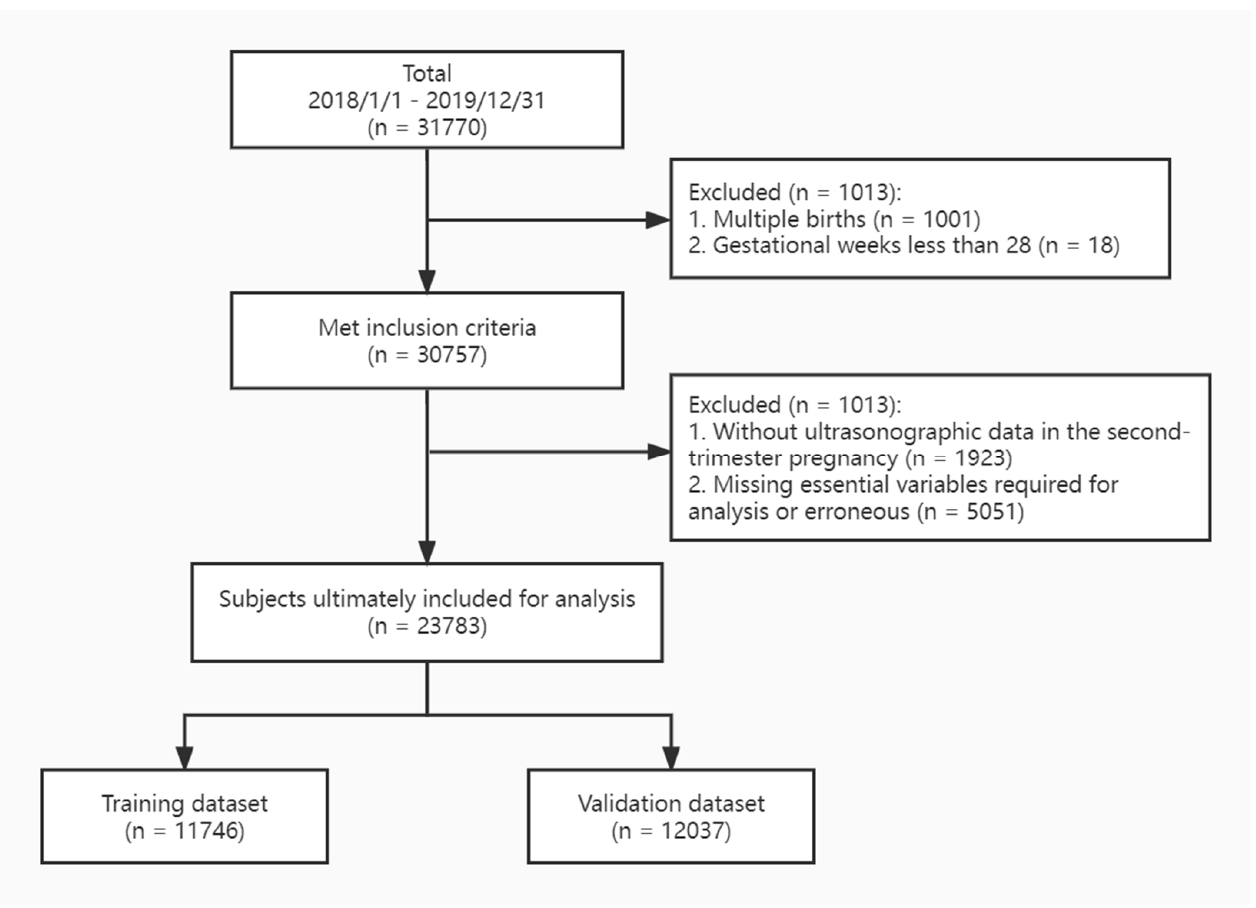
Figure 1. Flowchart illustrating pregnant women included in the study.